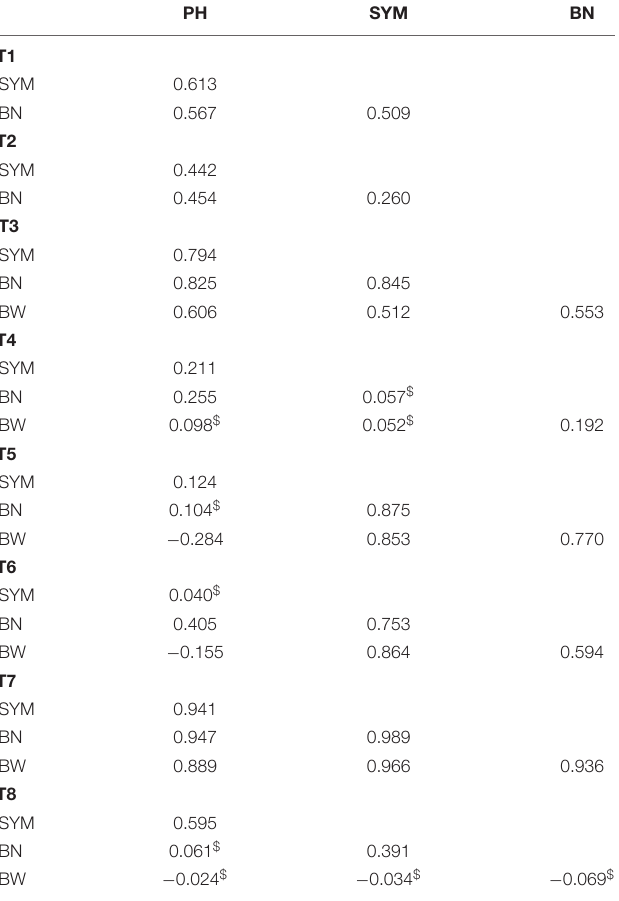
TABLE 3 | Correlation coefficients among the investigated traits measured from RILs used in this